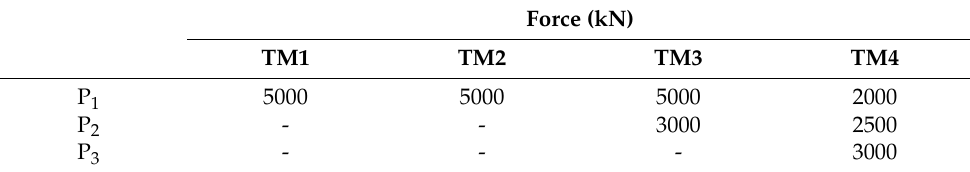
Figure 4. Deformed shape of target model. Table 2. Details of applied force for target models.